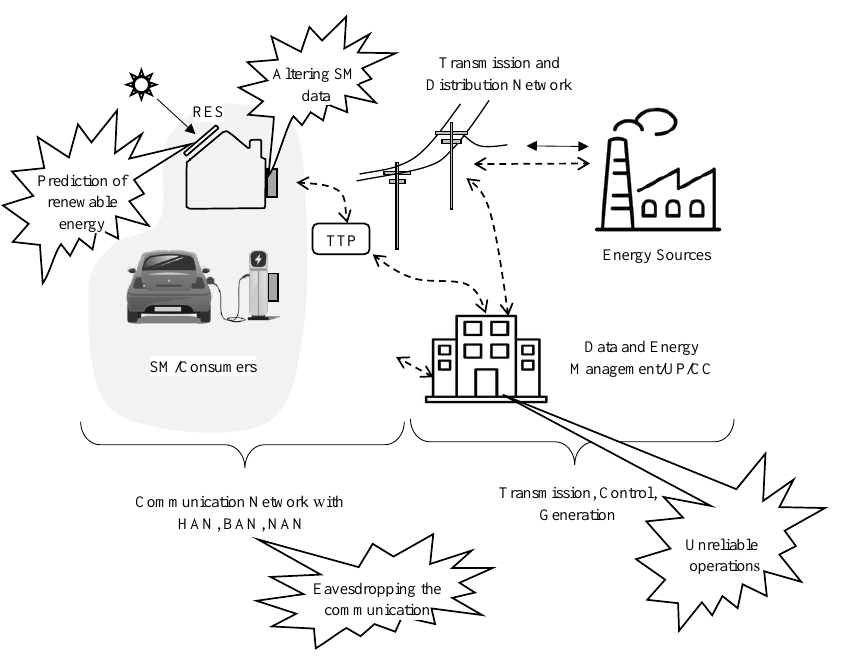
Figure 3. Threat model of SM privacy in SGs. The solid lines denote flow of power, and the dashed lines denote the information